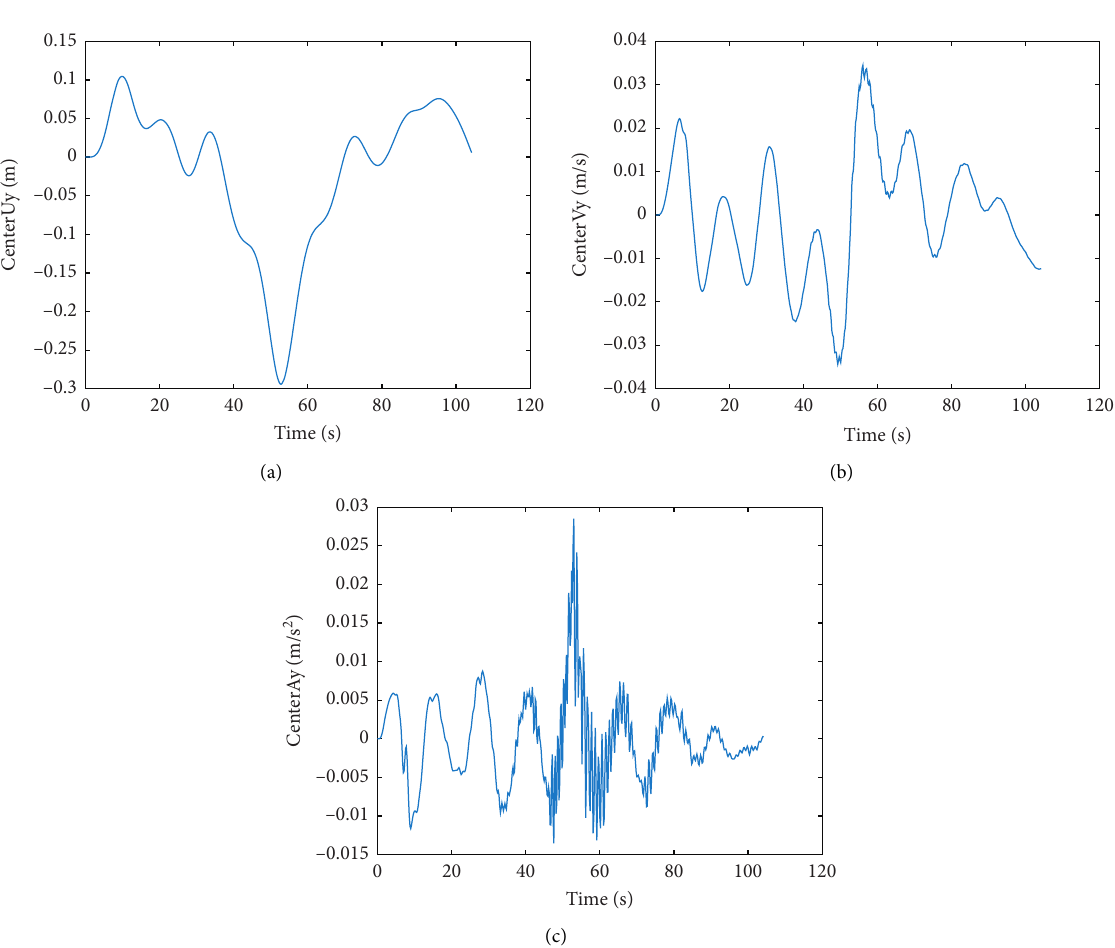
Figure 9: The finite element transient dynamic analysis results: (a) time-history results of vertical displacement in the middle of the span for dynamic coupling analysis of vehicle-bridge system; (b) time-history results of vertical speed in the middle of the span for dynamic coupling analysis of vehicle-bridge system; (c) time-history results of vertical acceleration in the middle of the span for dynamic coupling analysis of the vehicle-bridge